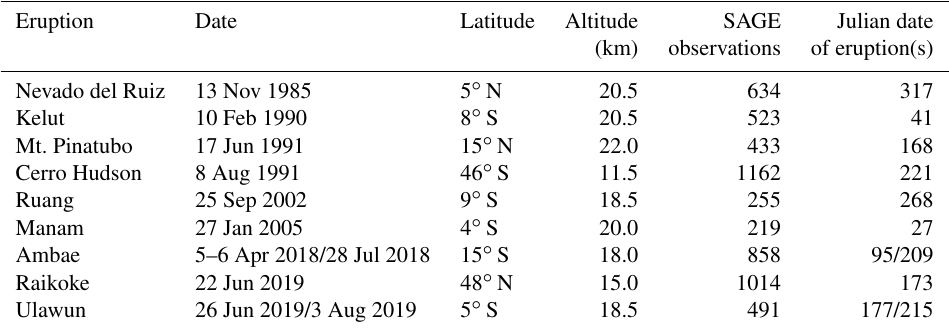
Table 2. Volcanic events observable in the SAGE II (1984–2005) and SAGE III/ISS (2017–present) records including the total number of observations used in the